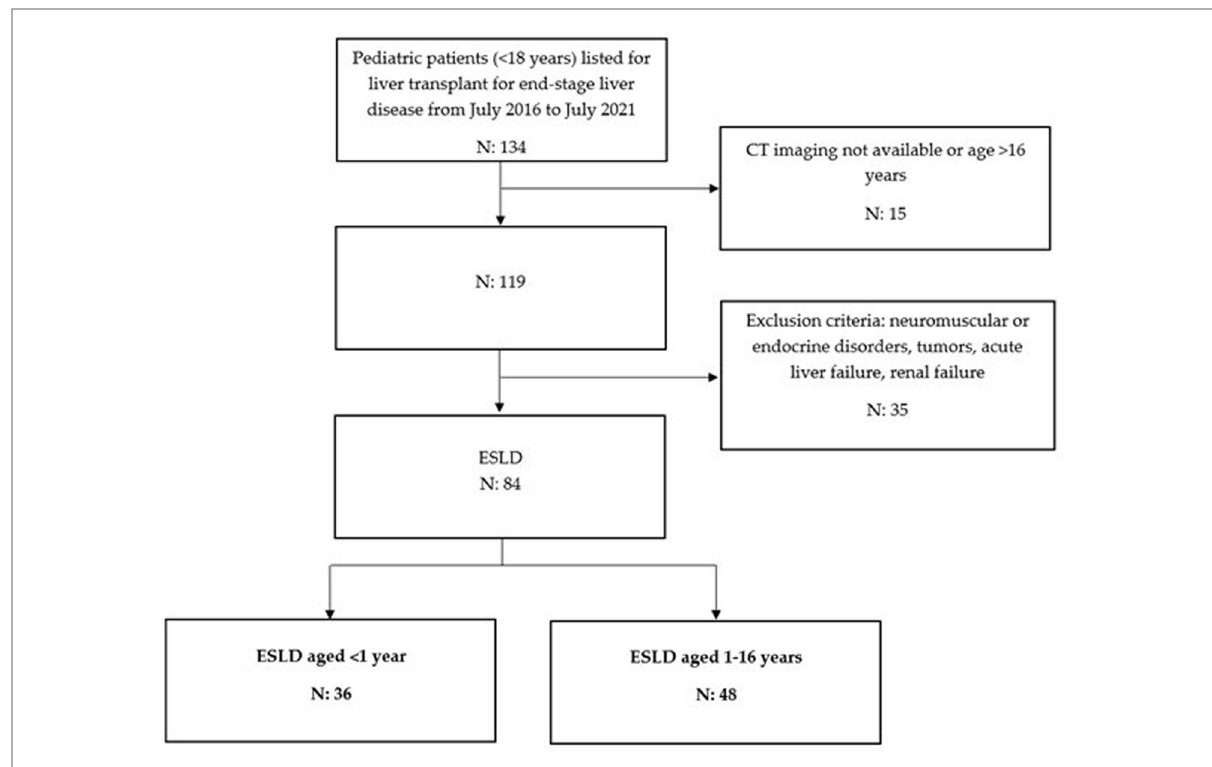
FIGURE 1 Enrolment fl owchart of the